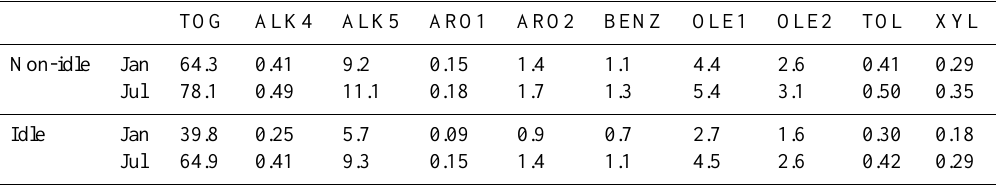
Table 4. Monthly total aircraft emissions (short tons) in January (Jan) and July (Jul) of total organic gases (TOG, the speciation of which is listed in Table 2) and CMAQ SOA precursors (alkanes (ALK4 and ALK5), aromatics (ARO1 and ARO2), benzene (BENZ), alkenes (OLE1 and OLE2), toluene (TOL), and xylene (XYL, which includes MXYL, OXYL, and PXYL)). Note that SOA production from ALK4, ARO1, and ARO2 was only considered from aircraft and that idle emissions, which are not included in AEDT emissions by default, were only considered in sensitivity simulations described in Sect. 3.2 and 3.4. TOG ALK4 ALK5 ARO1 ARO2 BENZ OLE1 OLE2 TOL XYL Non-idle Jan 64.3 0.41 Idle Jan